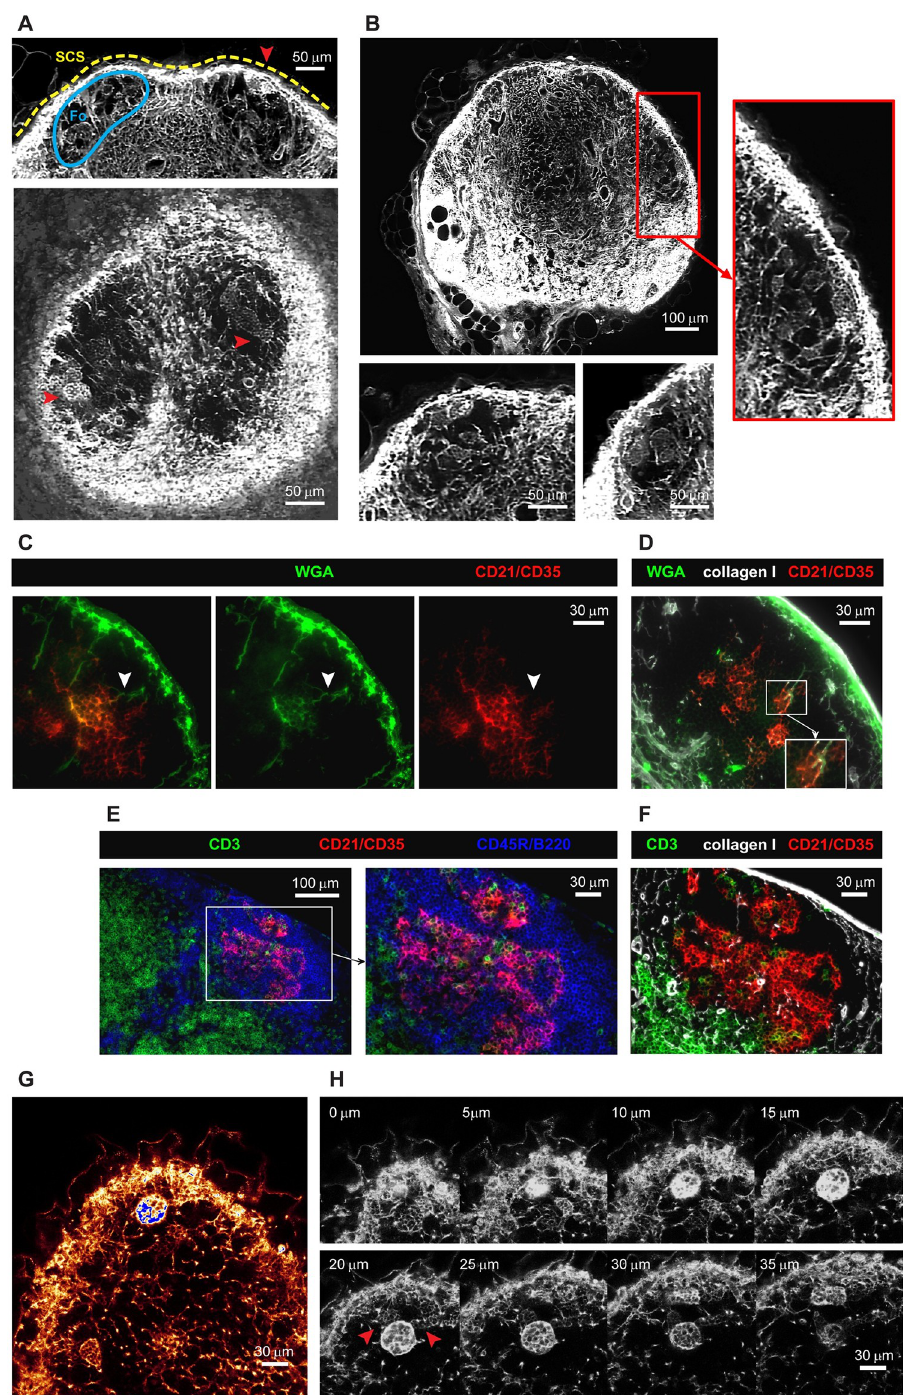
Fig 4. The follicular conduit. Three-dimensional EVIS images of a popliteal LN with WGA-labeled conduit paths contain brightly labeled multilobular spaces (red arrowheads) within the otherwise unstained B cell Fo underneath the SCS that can be repeatedly seen in 3D projections of 20 μ m thickness (A) and 2D image slices (B). In immuno-labeled tissue sections of WGA-perfused inguinal LNs, WGA (green) is found in follicular conduits descending from the SCS (white arrowheads) connecting to cellular clusters expressing the FDC marker CD21/CD35 (C, D). The morphology and location of WGA-labeled cell clusters within B cell follicles (D) are generally consistent with the anatomy of FDCs in these regions (E, F) as co-staining with markers for B cells (CD45R/B220), T cells (CD3), and collagen I